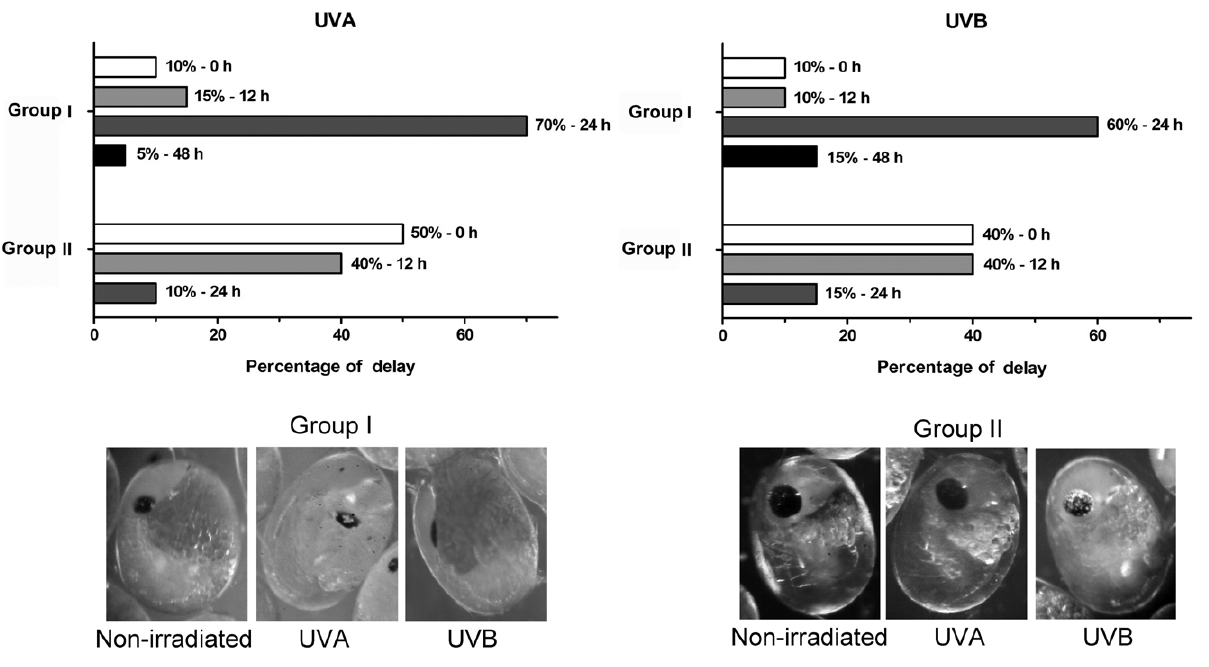
Figure 3. Developmental timelines of Macrobrachium olfersii embryos from groups I and II following UVA and UVB exposure. Data are presented as a